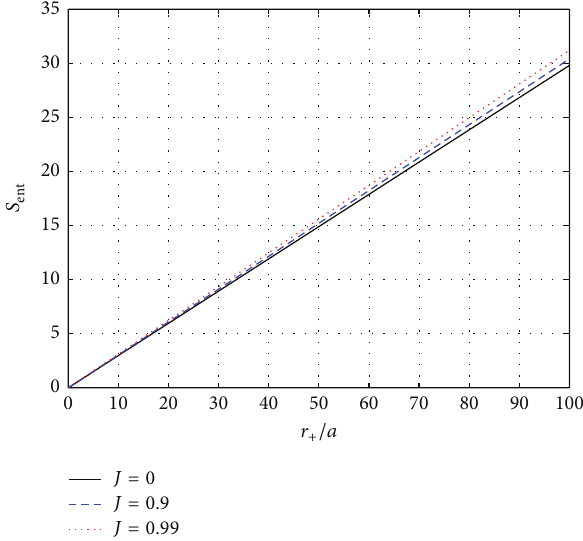
Figure 2: The entanglement entropy of massless fermion field as a function of 𝑟 + /𝑎 with different value of 𝐽 = 0, 0.9, and 0 . 99.